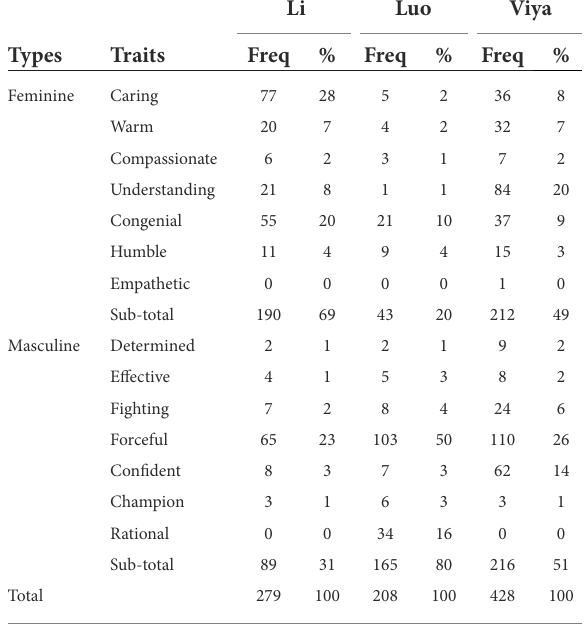
TABLE 4 Frequencies of personality